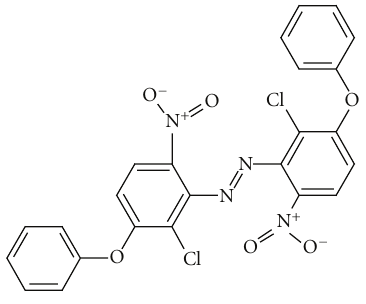
Scheme 2: chemical structure of the major oxidation product of aclonifen.